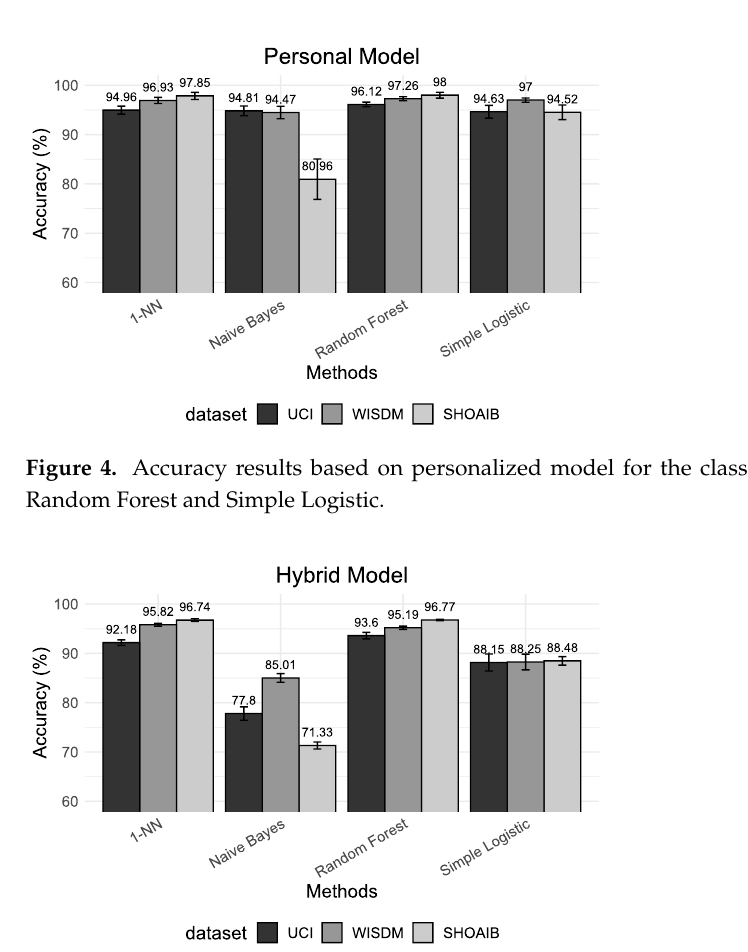
Figure 3. Accuracy results based on universal model for the classifiers 1-NN, Naive Bayes, Random Forest and Simple Logistic.